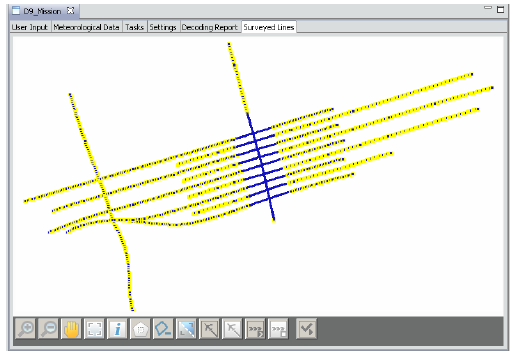
Figure 2. Flight lines displayed by GIS viewer